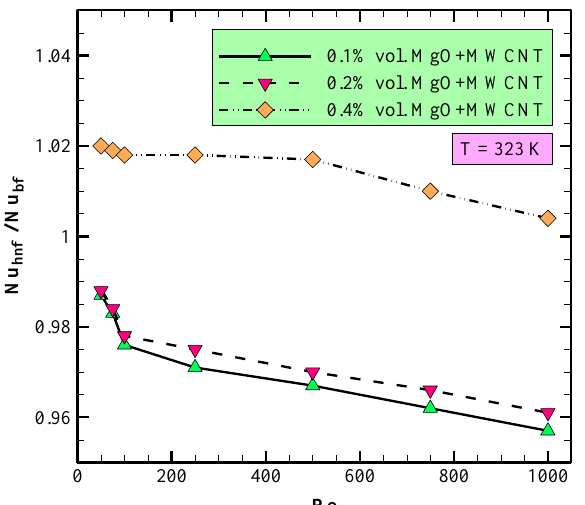
Figure 11. Effects of HNF with different VF on average Nu ratio for different Re and inlet tempera- ture T = 323 K.